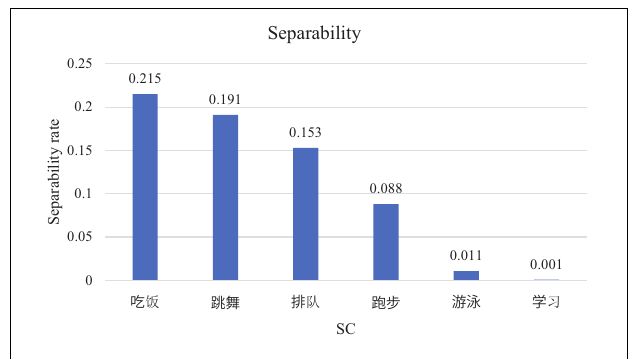
FIGURE 1 | Separability of the selected